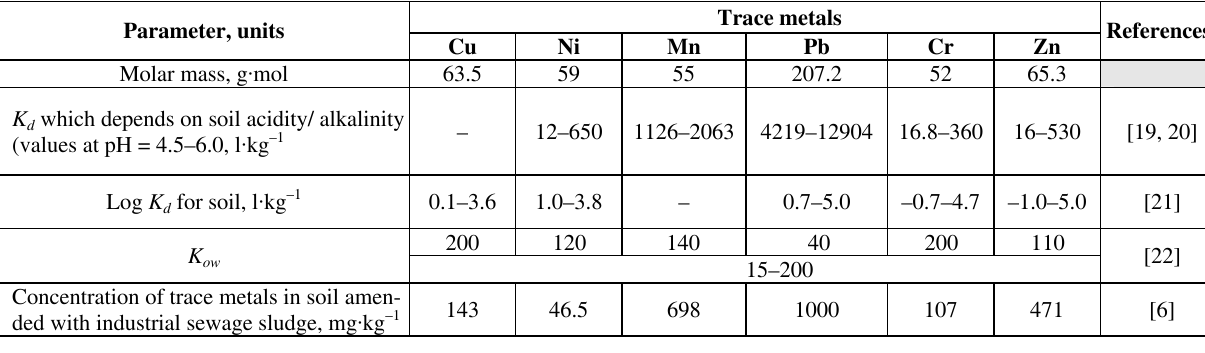
Table 2. Specific values for TMs and molar masses Parameter,